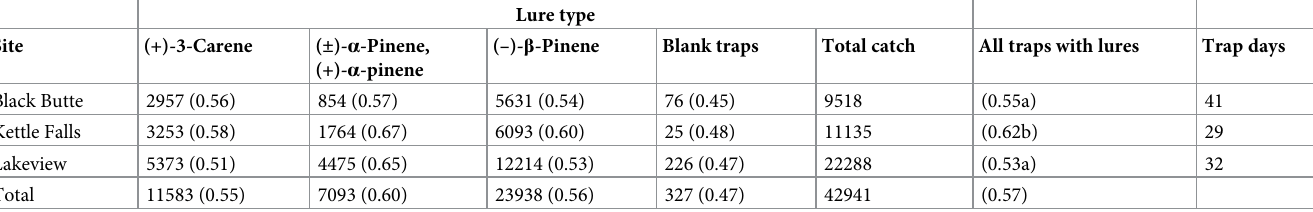
Table 1. Total number of Dendroctonus valens captured (mean female proportion) at each site and each monoterpene+ethanol lure type. Lure type